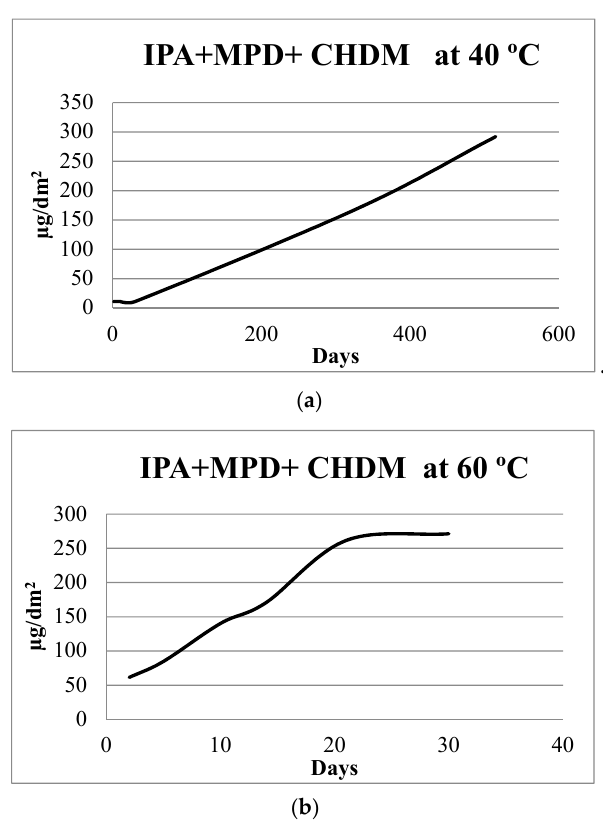
Figure 3. Comparison of migration into 50% ethanol of a polyester oligomer IPA + MPD + CHDM at